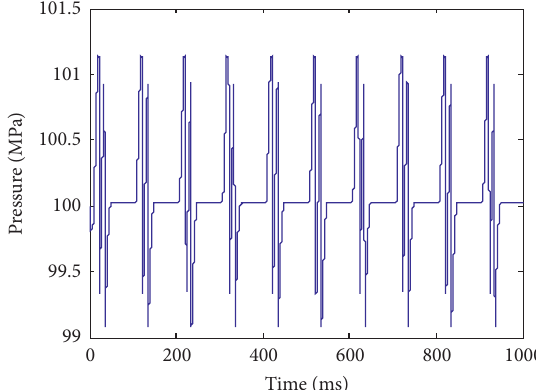
Figure 11: Changes in fuel pressure in high-pressure fuel line with two fuel injectors and one pressure reducing valve.